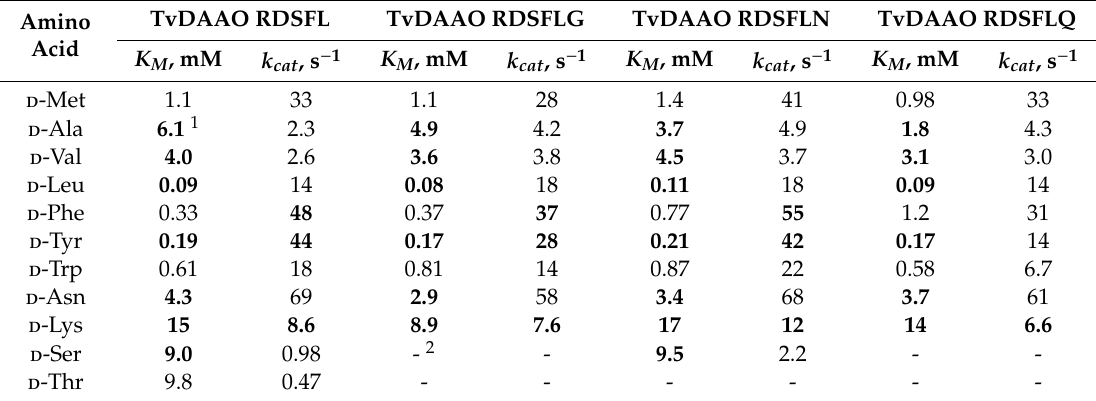
Table A2. Kinetic parameters of TvDAAO RDSFL, TvDAAO RDSFLG, TvDAAO RDSFLN